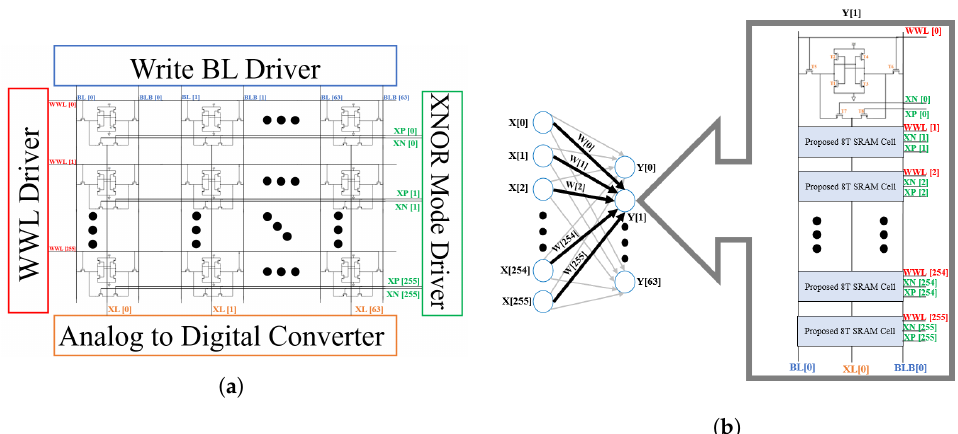
Figure 2. ( a ) Proposed XNOR-SRAM Architecture. ( b ) Single Neuron Calculation.